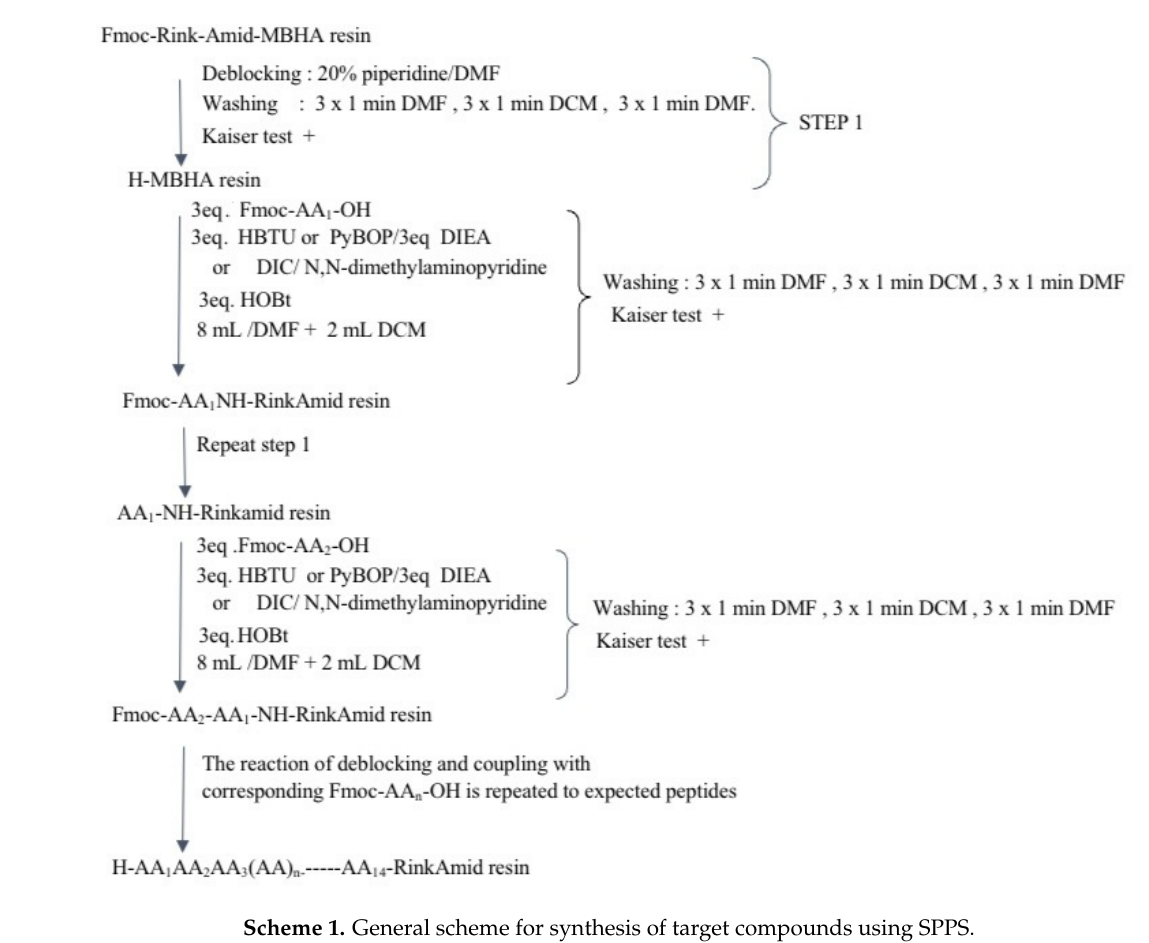
Scheme 1. General scheme for synthesis of target compounds using SPPS. Table 1. Structure and analytical data for newly synthesized